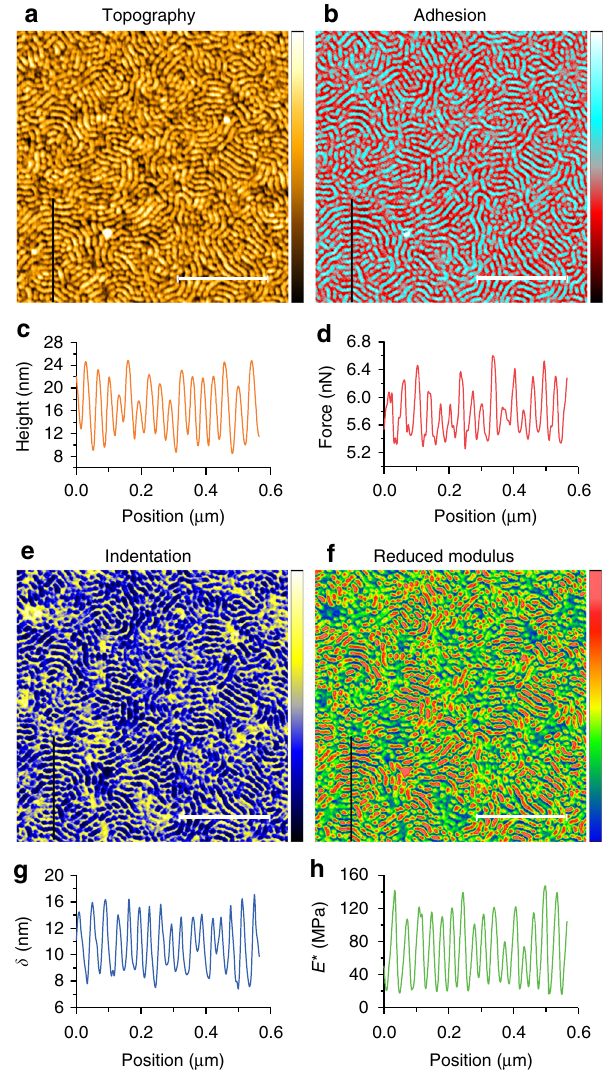
Fig. 6 High spatial resolution NM of a SEBS polymer. The same probe was used to map a SEBS polymer. a Topography. b Map of the adhesion force. c Height pro fi le obtained from a . d Pro fi le of the adhesion forces obtained from b . e Map of the indentation depth ( δ ). f Map of the reduced elastic modulus calculated from DMT theory. g Pro fi le of δ obtained from e . h Pro fi les of the elastic modulus obtained from f . Scale bar, 500 nm